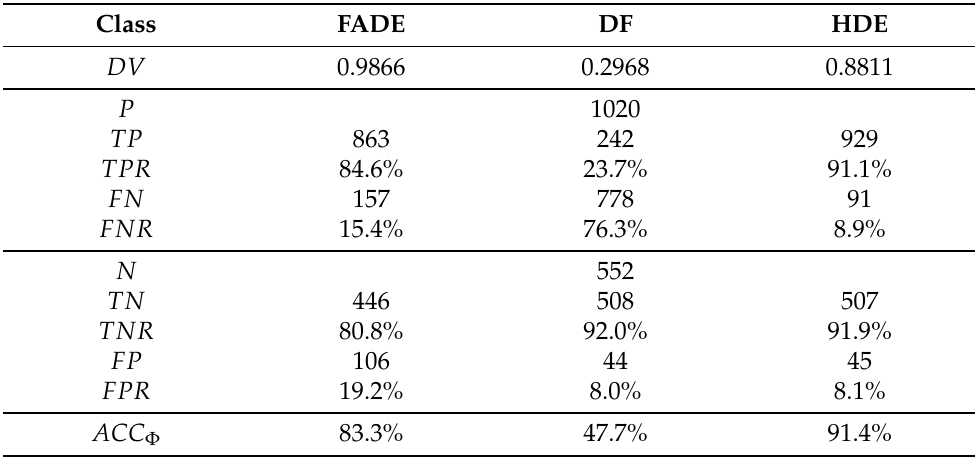
Table A1. Accuracy report for hazy/haze-free image classification task using haze density evaluators on new